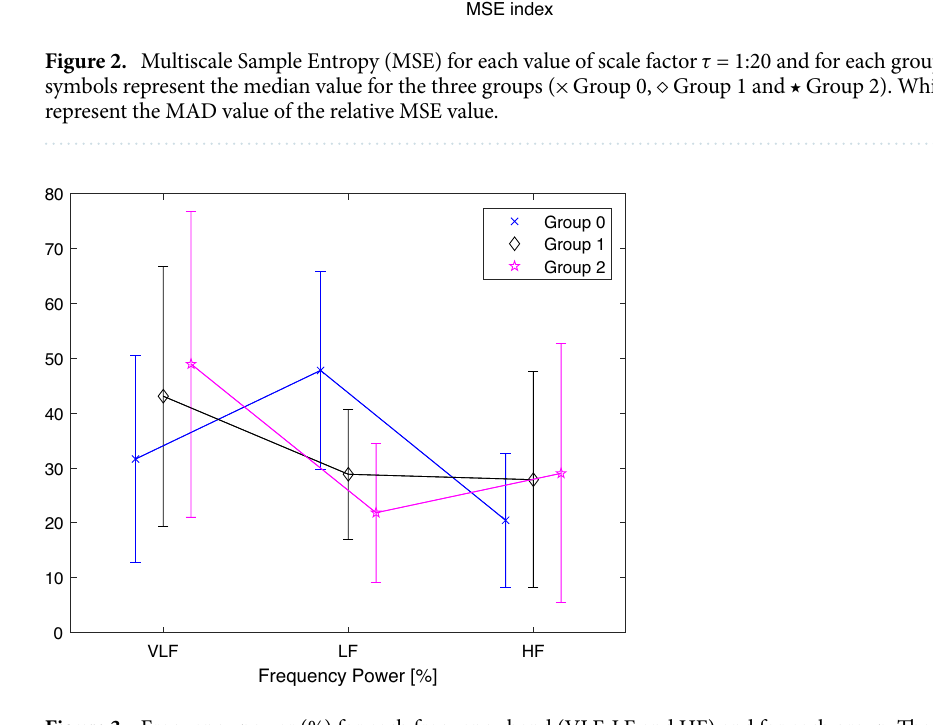
Figure 3. Frequency power (%) for each frequency band (VLF, LF and HF) and for each group. The symbols represent the mean value ( × Group 0, ⋄ Group 1 and ⋆ Group 2). Whiskers represent the standard deviation value of the relative Frequency Power